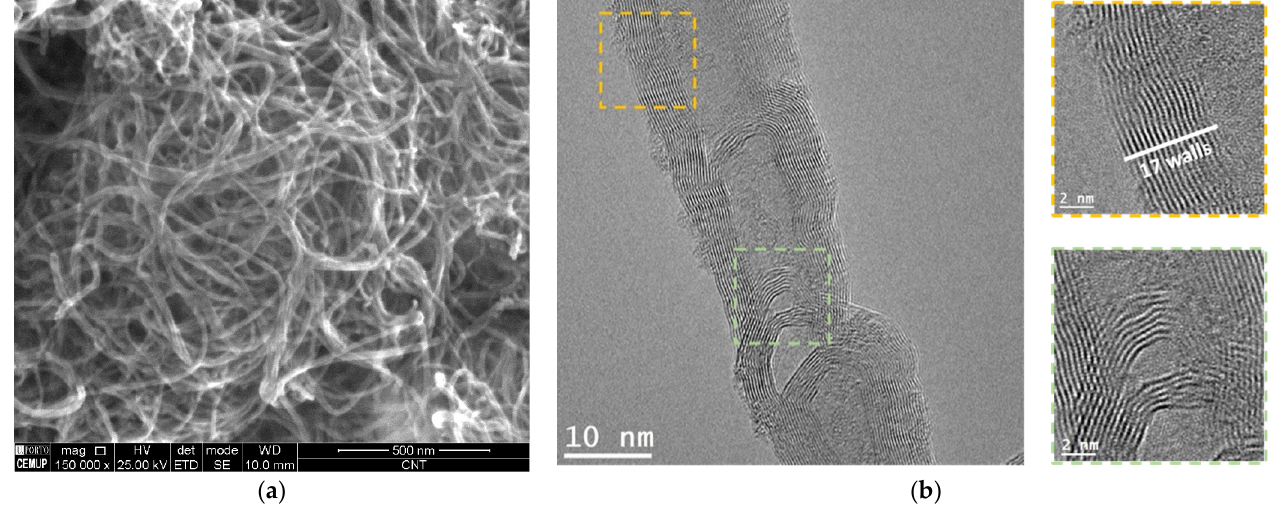
Figure 4. ( a ) SEM image of the as-received CNTs, ( b ) HRTEM image of the CNTs showing some structure details as the multi-walls (yellow) and concentric CNTs (green).